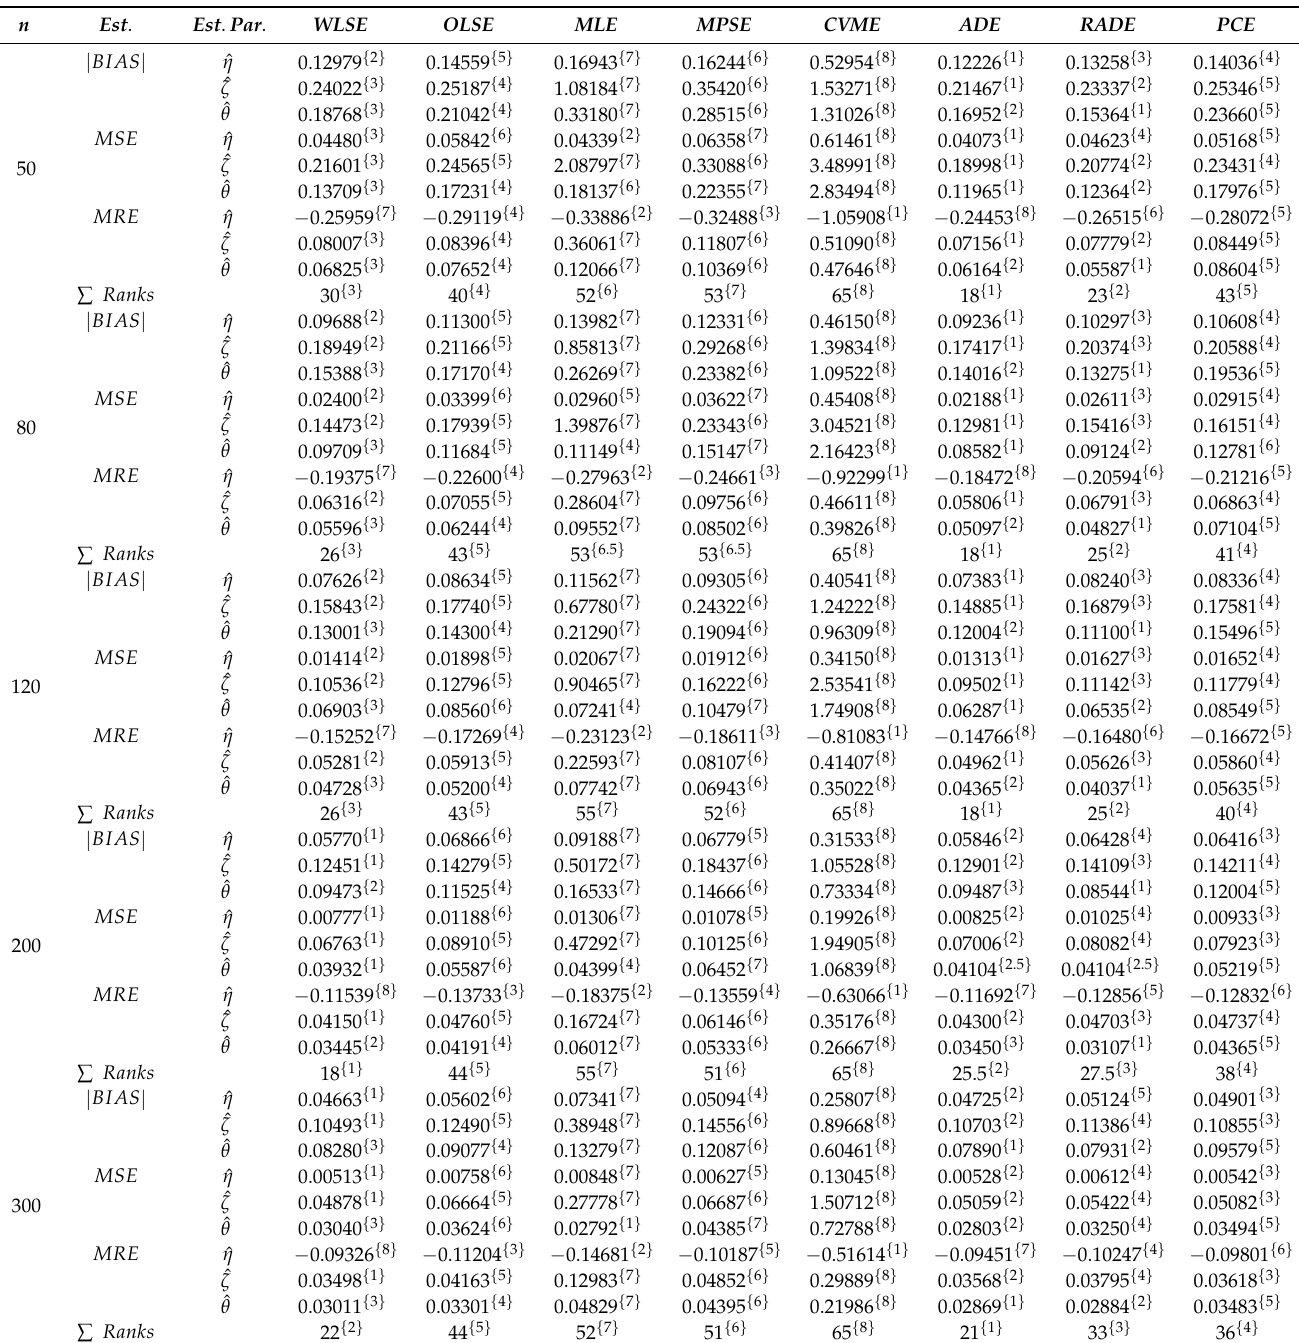
Table 4. Simulated results of the E-NPF distribution for Θ = ( η = − 0.50, ζ = 3.00, θ = 2.75 ) T